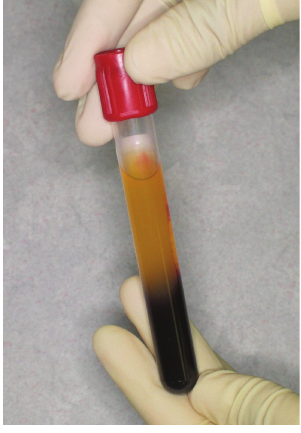
Figure 4: Formation of